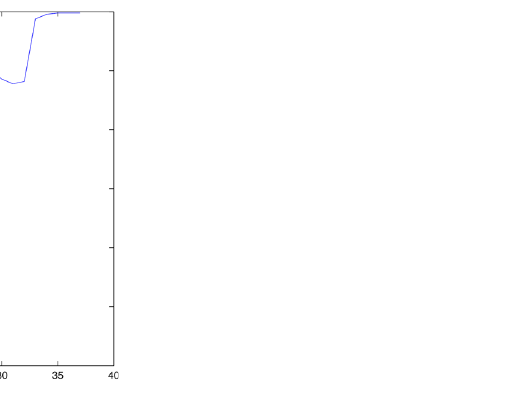
Fig 7. Optimal EOFs distribution in VE-DINEOF